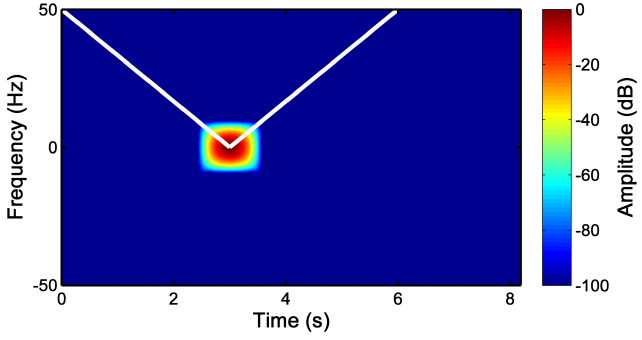
Figure 13. Heisenberg’s box of the atom of the Slepian window ( B W = 11.55 Hz, T W = 692.8 ms), optimized for detecting the LSH during the start-up transient of the high-power, high-voltage IM given in Appendix B. The white line marks the estimated trajectory of the LSH in the time-frequency